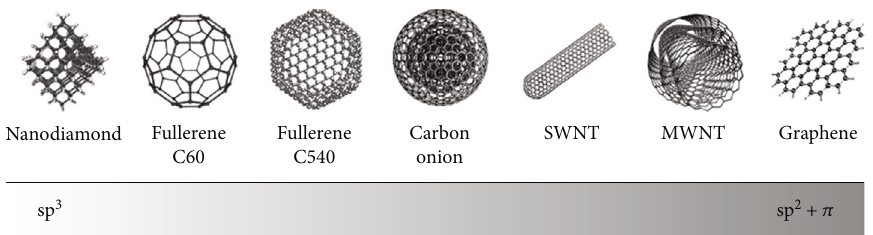
Figure 1: Carbon-based nanomaterials in various levels of hybridization. The predominant hybridization state of carbon-carbon bonds controls several chemical and electrical characteristics of carbonaceous